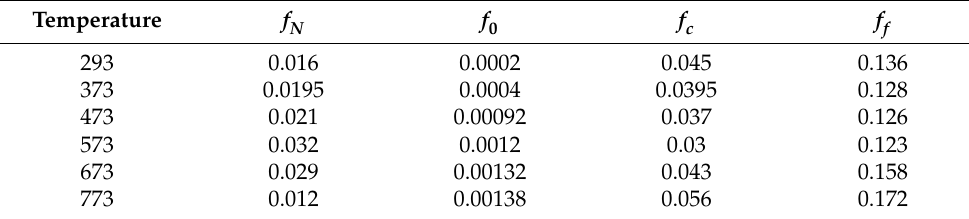
Table 7. Damage parameter values at different